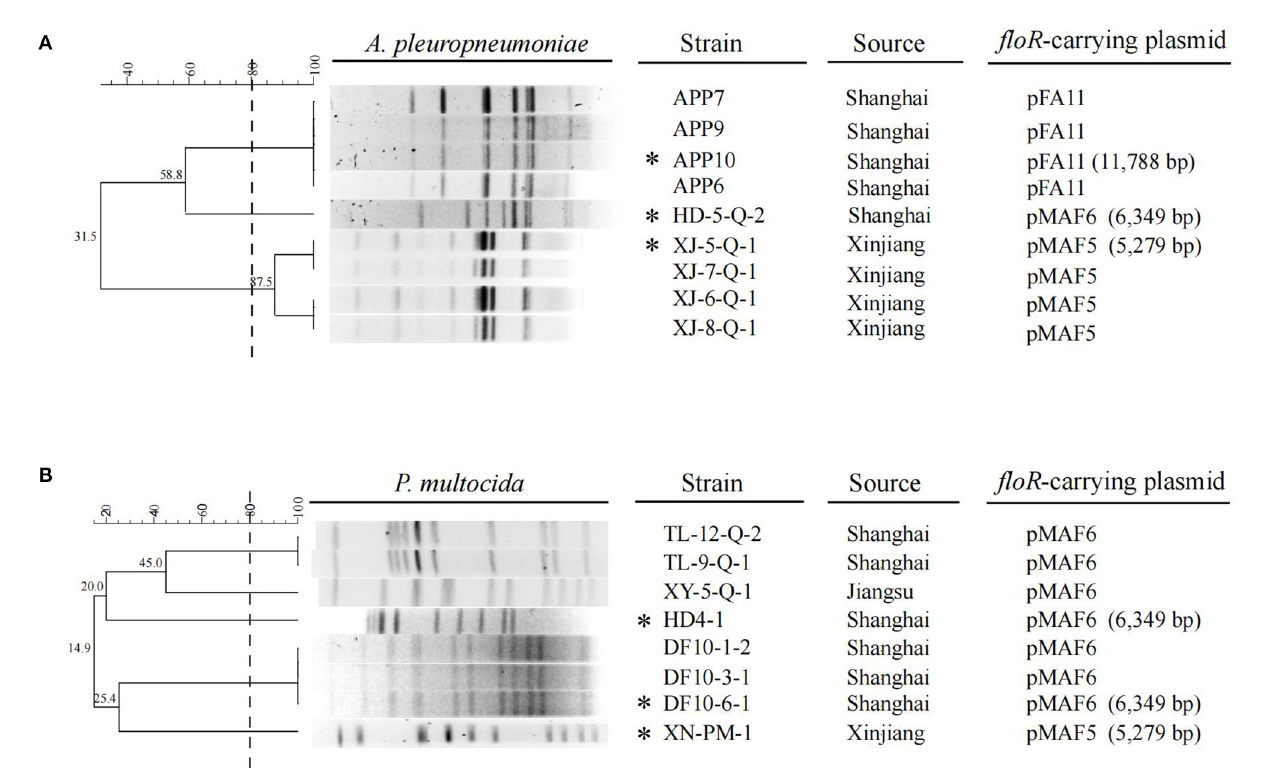
FIGURE1 Apa I-PFGE patterns and dendrogram of the 9 floR -positive A . pleuropneumoniae isolates (A) and 8 floR -positive P . multocida isolates (B) in this study. The dashed line on the dendrogram indicates 80% similarity. The strain name, source and the floR -carrying plasmid corresponding to each isolate are also presented. The isolates marked with an asterisk are the ones characterized by WGS, while the floR -carrying plasmids in the isolates without asterisk are identified by specific PCRs.